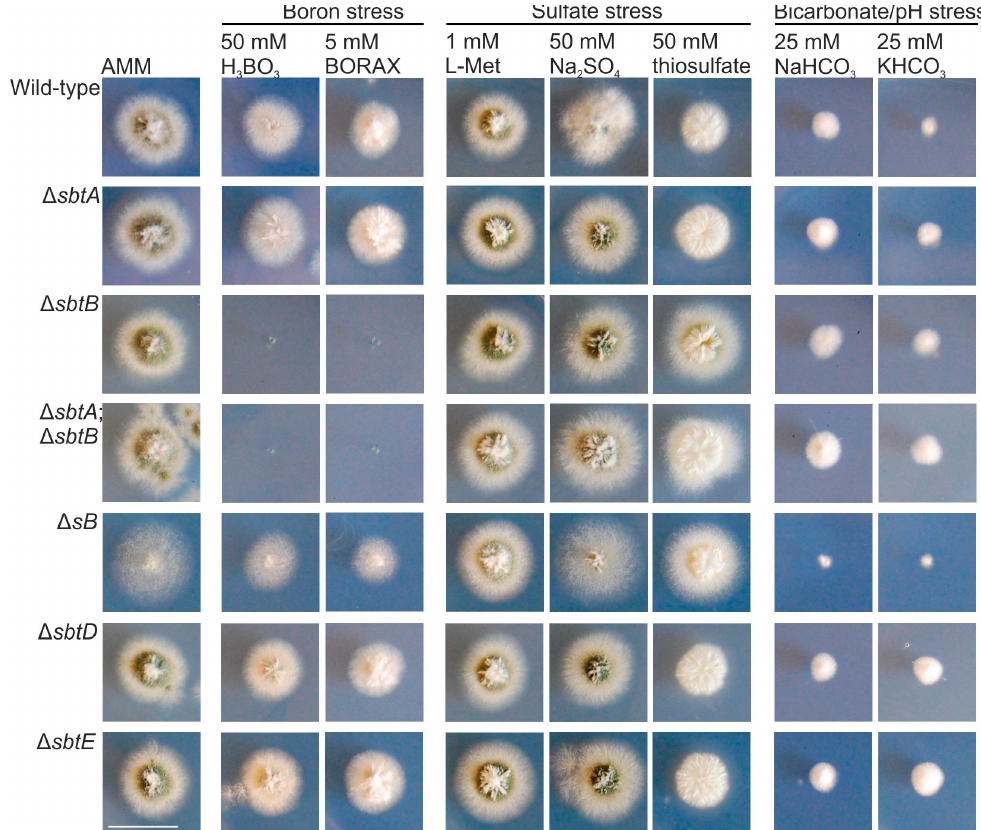
Figure 4. Sensitivity of sbt deletion mutants to stress. Phenotype of wild-type, Δ sbtA , Δ sbtB , ( Δ sbtA ; Δ sbtB ), Δ sB , Δ sbtD and Δ sbtE strains after 48 h of cultivation at 37 °C in AMM and AMM with 50 mM boric acid, 5 mM Borax, 1 mM L-methionie, 50 mM sodium sulfate, 50 mM thiosulfate, or 25 mM of sodium or potassium bicarbonate. Scale bar = 2 cm.